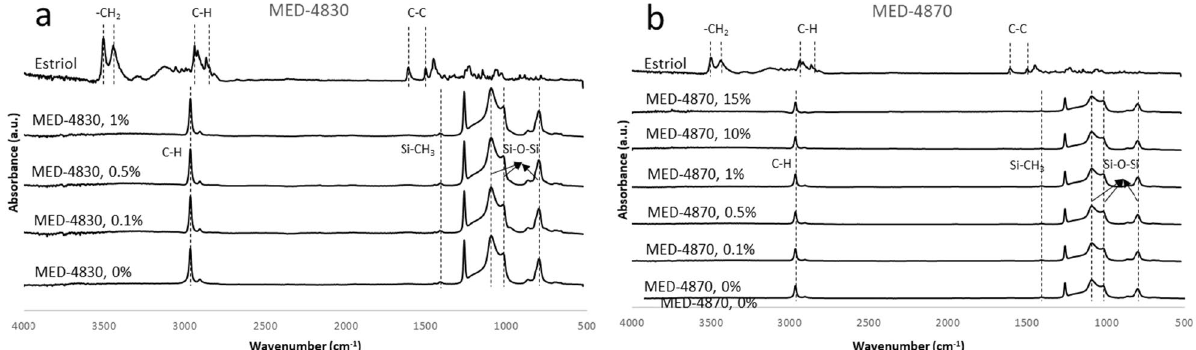
Figure 5. Fourier transform infrared (FTIR) spectra of MED-4830 ( a ) and MED-4870 ( b ) systems. MED- 4870 ring with 0.1% estriol loading ring post submersion—treated with SVF (pH 4.2) for a period of 4-month at 35 ± 2 °C. The peaks of estriol and silicone were lined out and marked with chemical structures in figures. No clear peak of estriol in silicone samples was because the low ratio of estrio:silicone, the silicone mask the characteristic peaks of